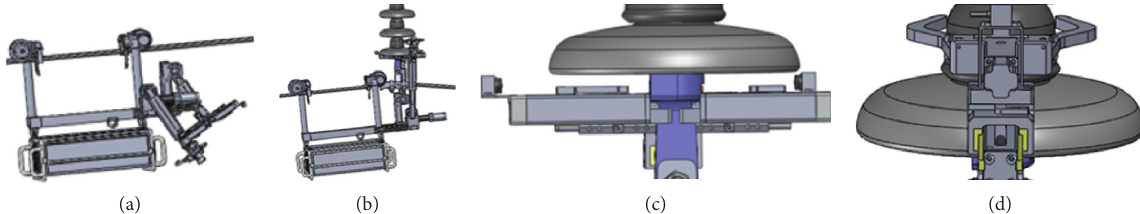
Figure 2: Insulator replacement operation planning entity motion simulation. (a) Initial posture. (b) Working posture. (c) Bowl head plate clamping. (d) Insulator steel cap clamping.